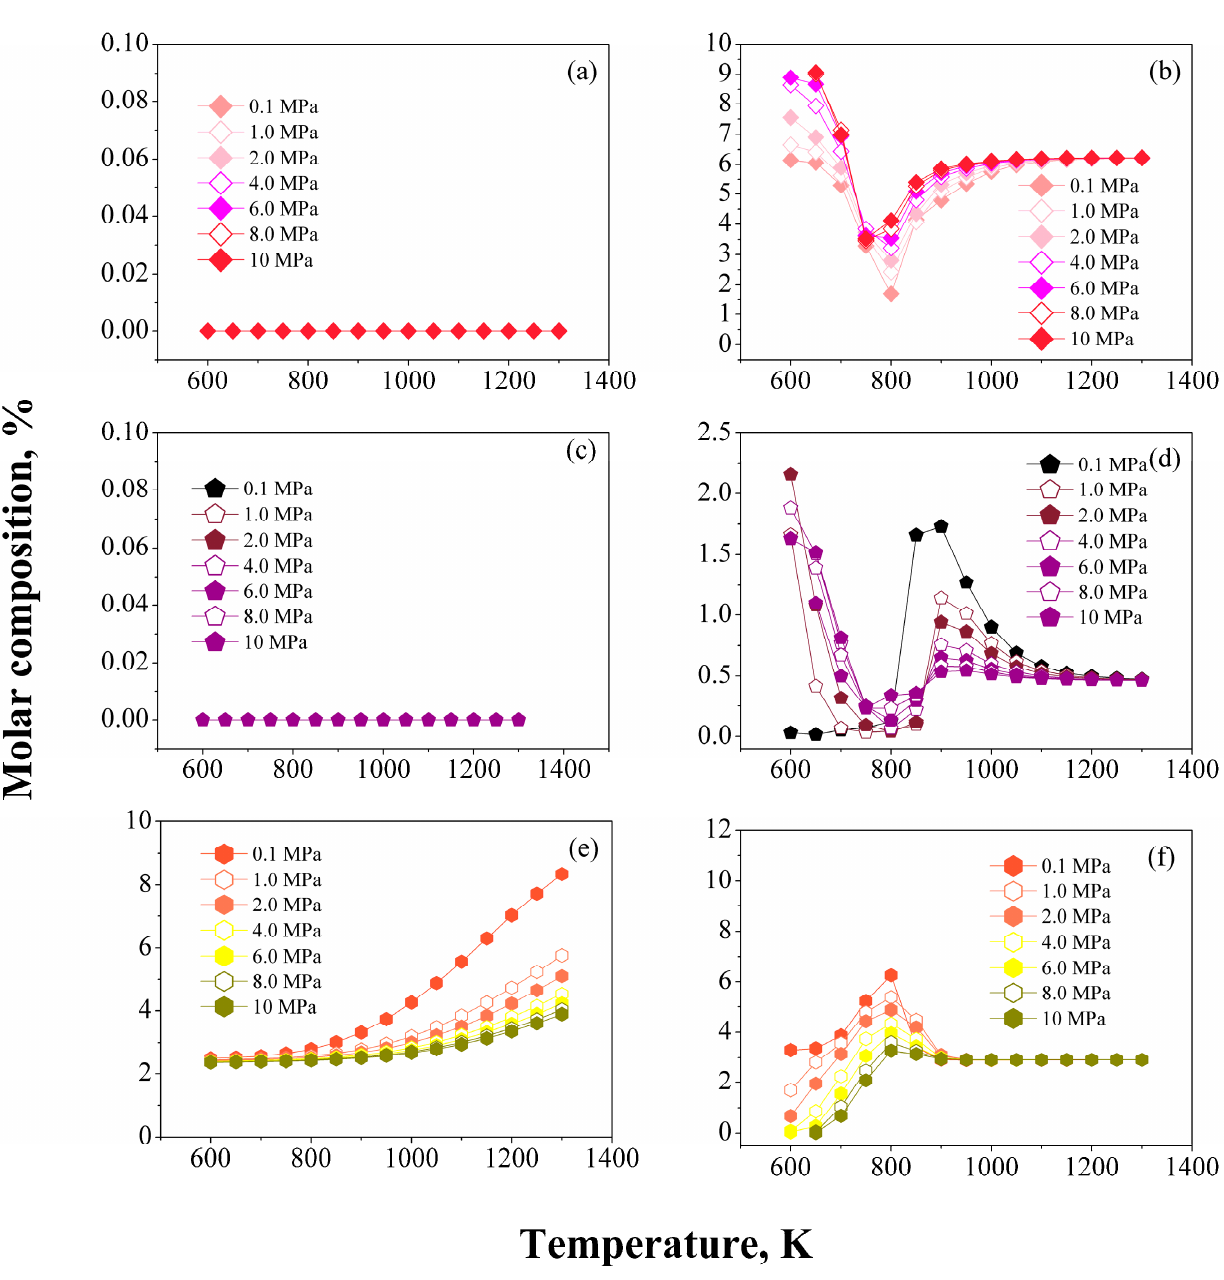
Figure 4. Effect of pressure on liquid products: ( a ), ( c ), ( e ) Equilibrium. ( b ), ( d ), ( f ) Catalytic. ( / ) Paraffins, ( / ) Naphthenes, and ( / ) Aromatics.